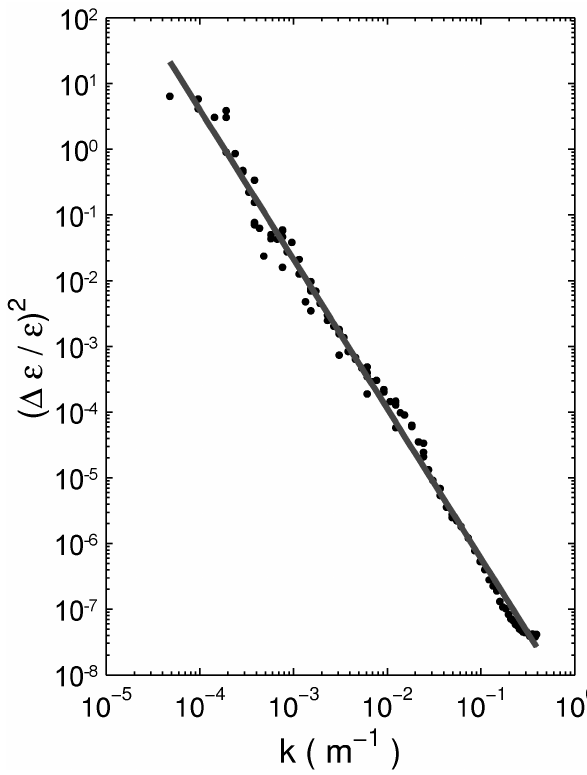
Fig. 3. Permittivity fluctuations spectrum (dots) and power-law fit (line) giving a slope of − 2 .